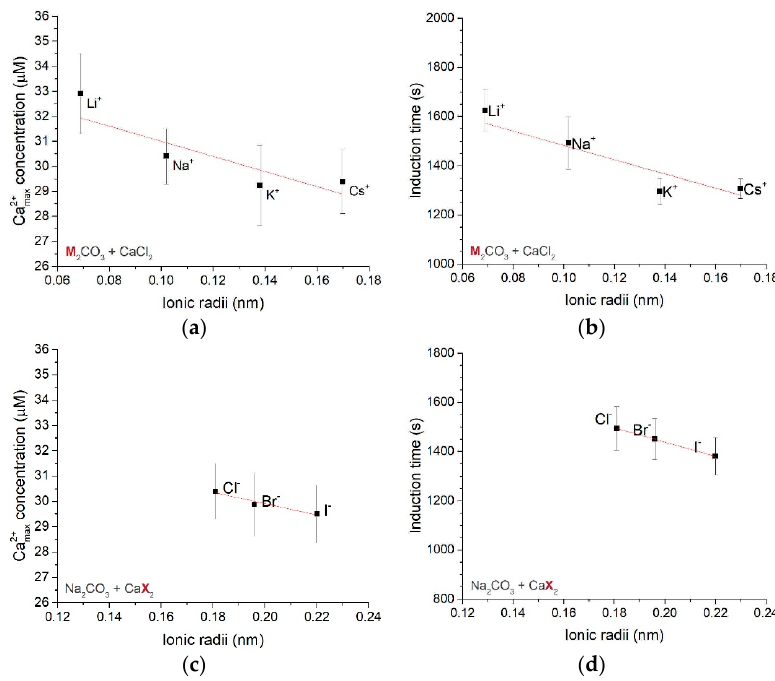
Figure 1 . Maximum free Ca 2+ concentration and corresponding induction time for type I titration experiments. ( a , b ) CaCl 2 was added to solutions of different carbonate sources (Li 2 CO 3 , Na 2 CO 3 , K 2 CO 3 , Cs 2 CO 3 ) placed in the reactor. ( c , d ) Na 2 CO 3 was always present in the reactor, and different calcium sources (CaCl 2 , CaBr 2 , CaI 2 ) were continuously added to the reactor. Errors bars show 2 σ N.